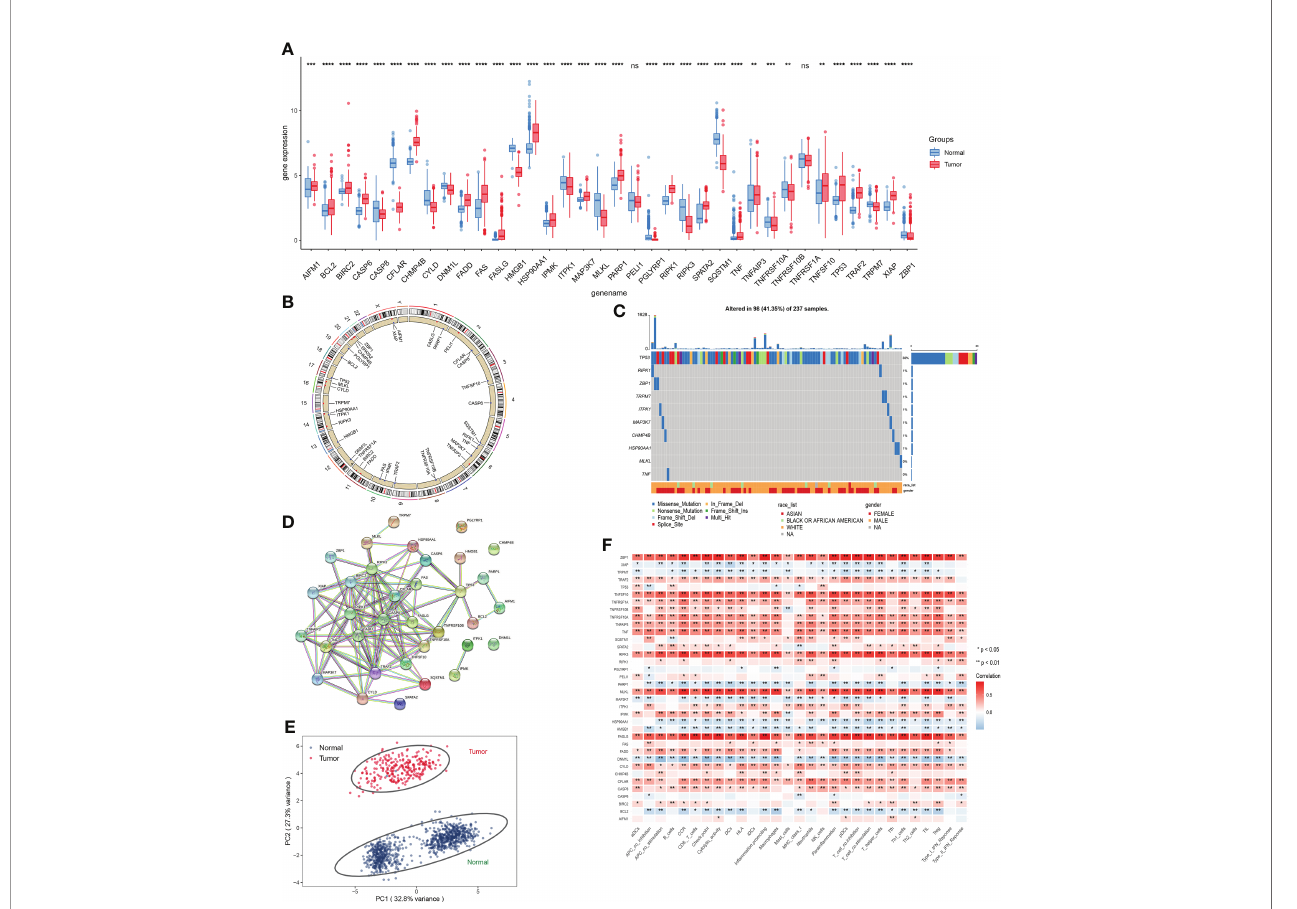
FIGURE 2 | Expression analysis of NRGs. (A) Expression level of NRGs between STSs and normal tissue. (B) The location of NRGs on chromosomes. (C) Frequency and type of mutations in NRGs. (D) Based on NRGs encoded proteins, the PPI network was constructed according to the interaction score of 0.9. (E) Principal component analysis (PCA) based on NRGs to distinguish STSs from normal tissues. (F) The correlation of the expression level of NRGs and immune cells. ns, p ≥ 0.05; *, 0.01 ≤ p < 0.05; **, 0.001 ≤ p < 0.01; ***, 0.0001 ≤ p < 0.001; ****p <